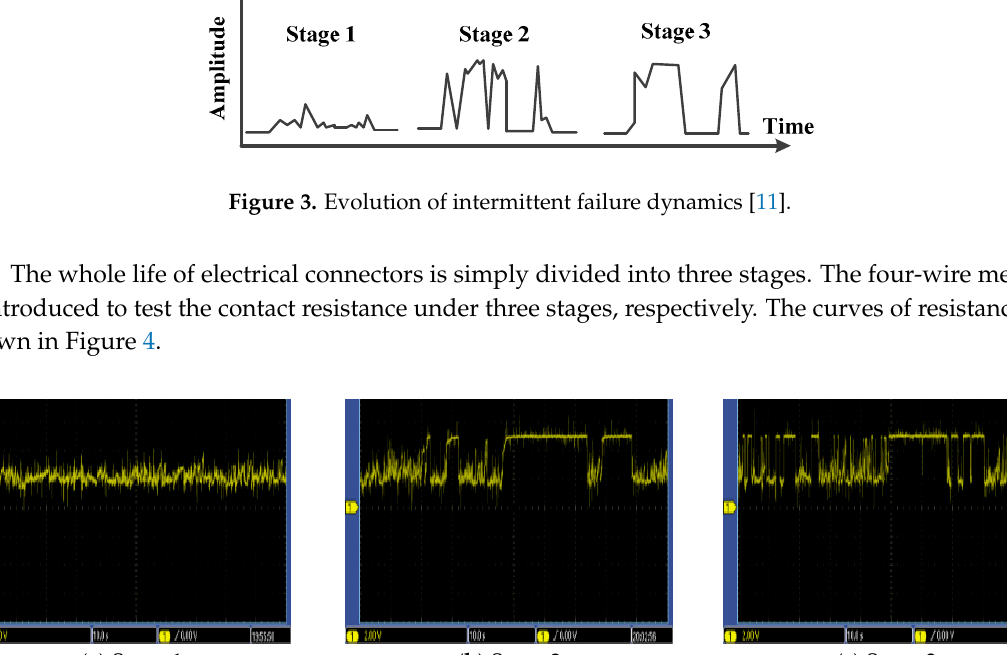
Figure 2. Degradation curve of contact resistance.